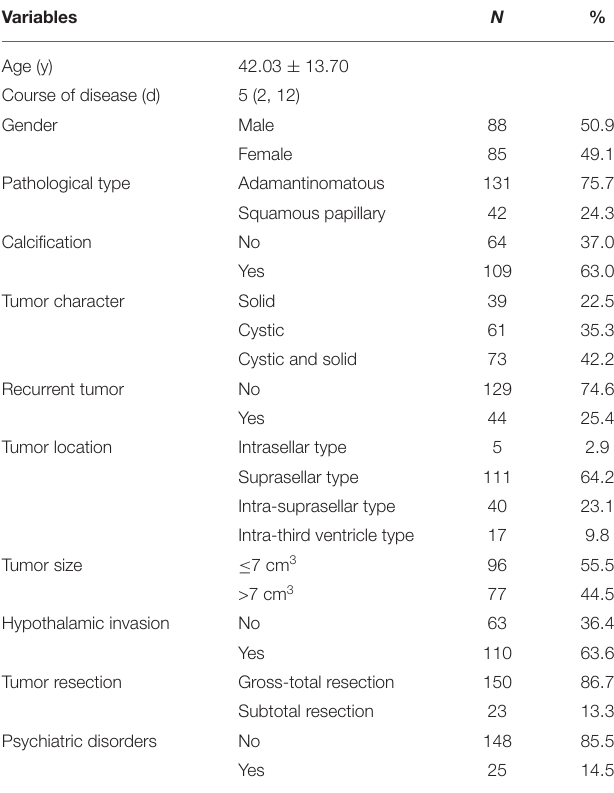
TABLE 1 | Characteristics of the